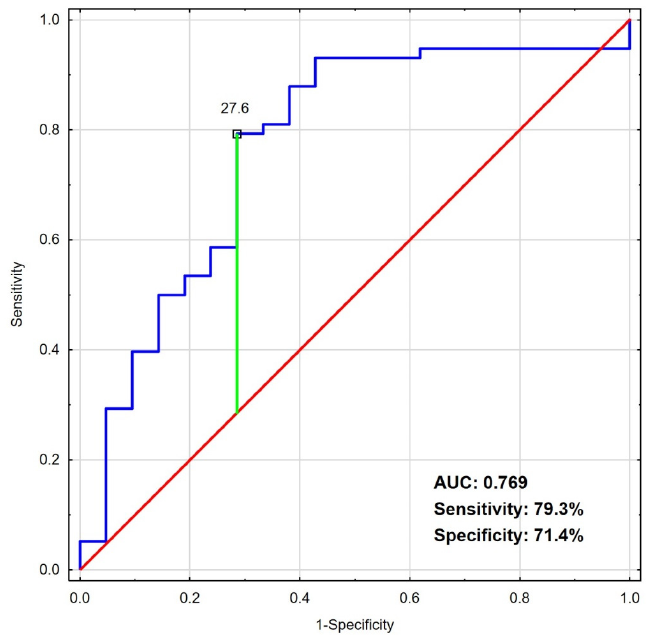
Figure 1. ROC analysis of NSE as a predictor of poor clinical outcome (CPC 3–5 or death). Abbre- viations: AUC—area under the curve; CPC—cerebral performance category; NSE—neuron-specific enolase; ROC—receiver operating characteristic.